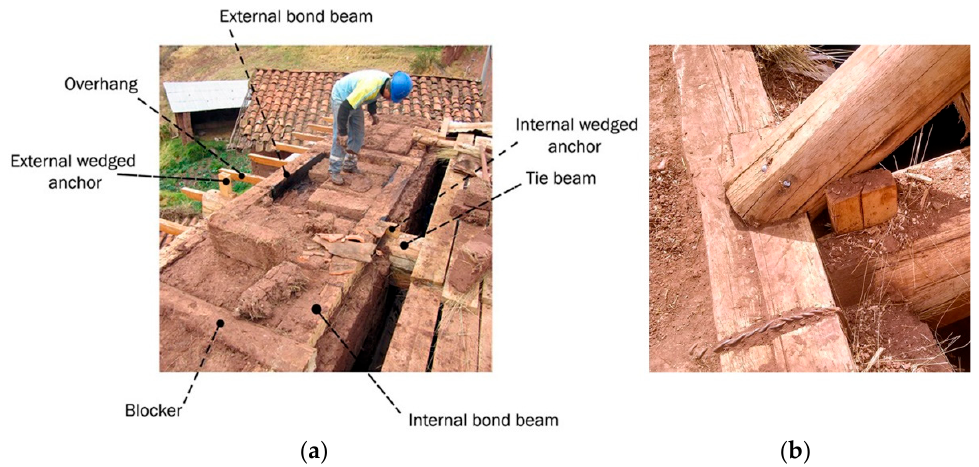
Figure 6. Implementation of the retrofitting plan in the Church of Kuñotambo: ( a ) configuration of tie beams—bond beam system at the southwest corner of the altar; ( b ) close view of the system of wall plates and tie beam, in connection with the inner part of the new roof rafters.